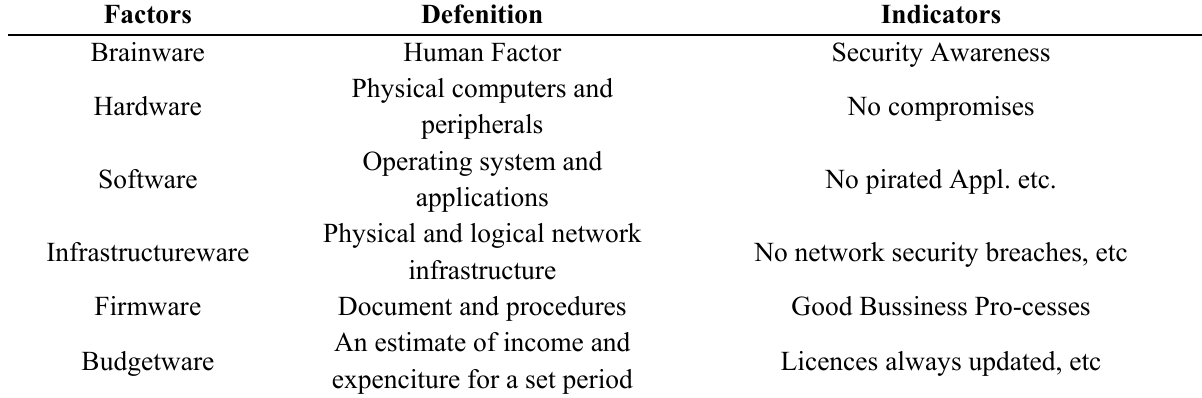
Table 4. Assessment Indicators for Six-Ware Cyber Security Framework